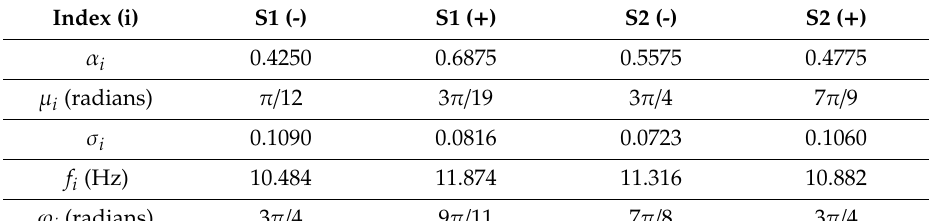
Table 3. Parameters used in [21] to generate normal heart sounds.